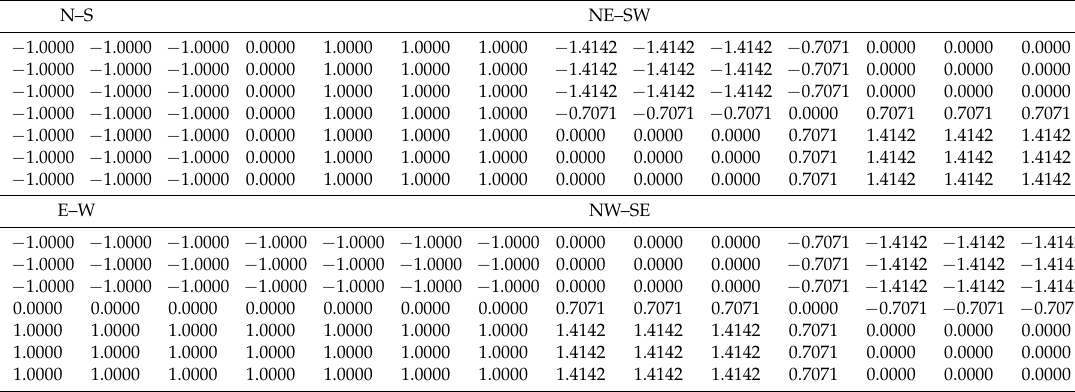
Figure 3. The selected optical images for manual lineaments extraction for ( a ) L8 band-6 (SWIR) and ( b ) S2A band-11 (SWIR) in addition to the radar images of ( c , d ) S1A VH and VV polarizations respectively. Table 3. The four applied principle directional filters with 7 × 7 kernel matrices.